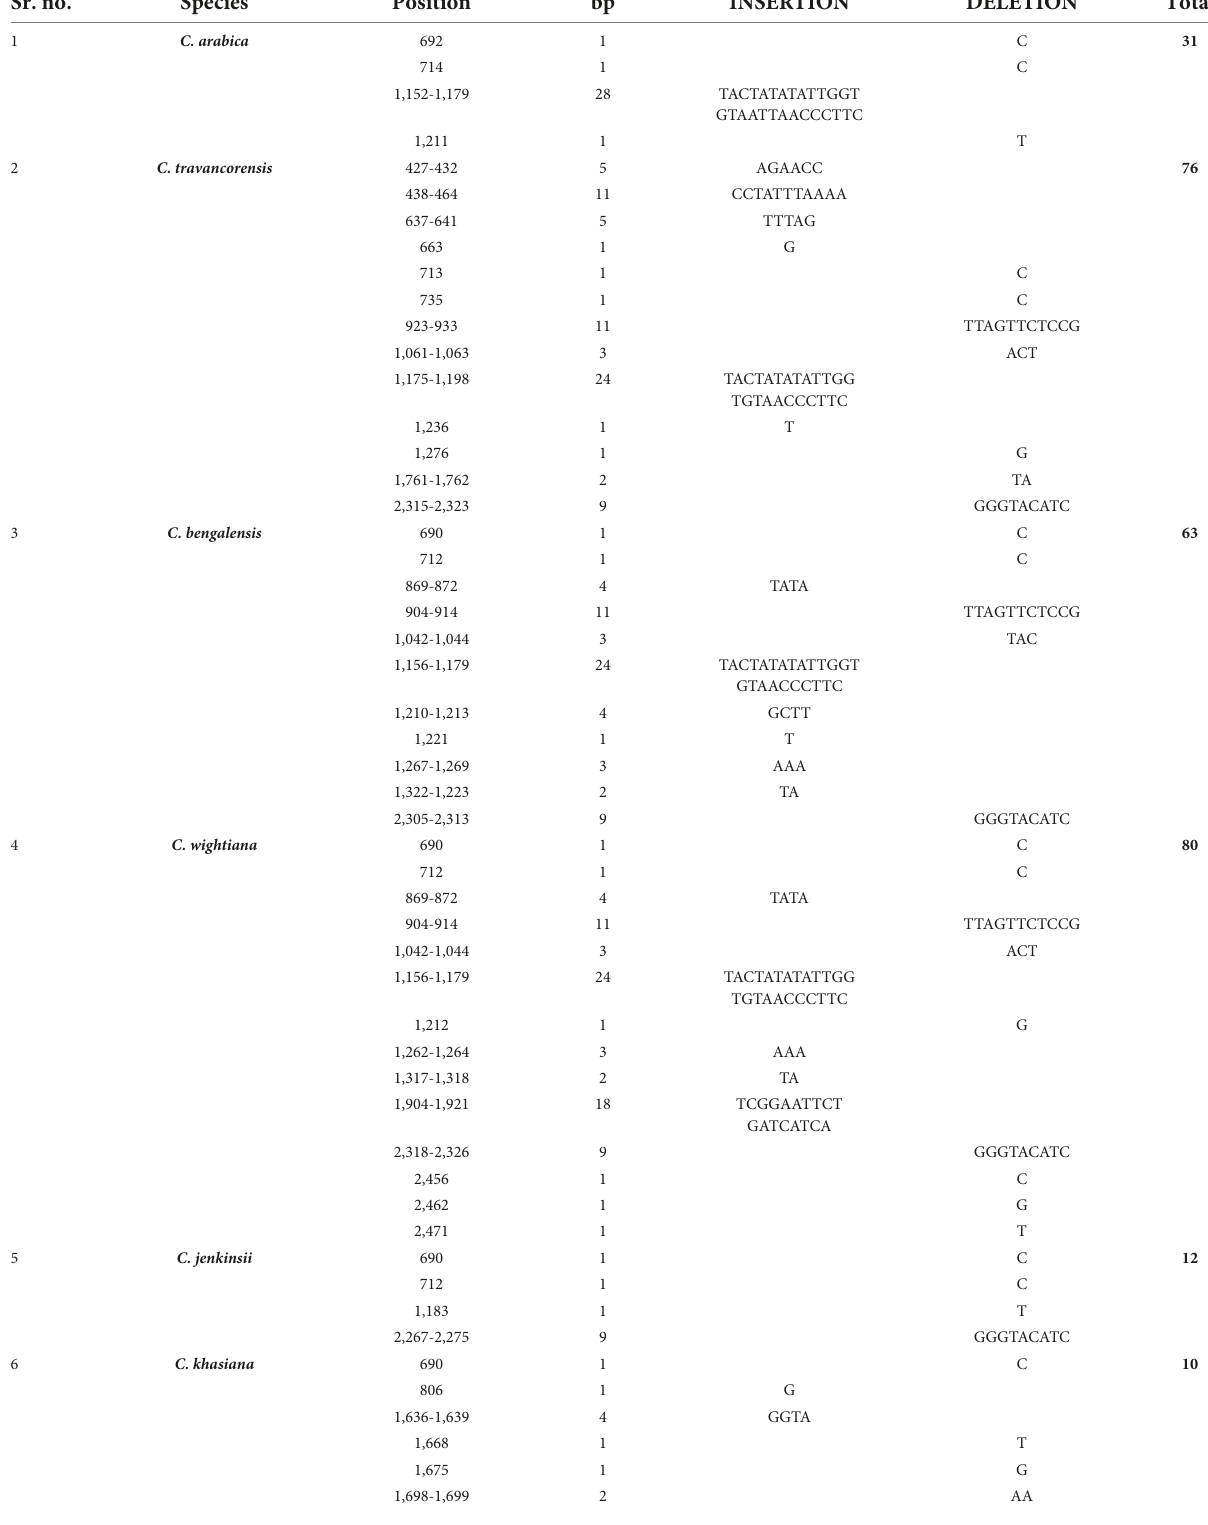
TABLE 4 Table depicting species specific Insertions and Deletions (InDels) causing frameshift (F) and non-frameshift (NF) mutation at the NAC25 gene sequence of six coffee species with reference to NAC25 gene of Coffea canephora (S.274). Sr.